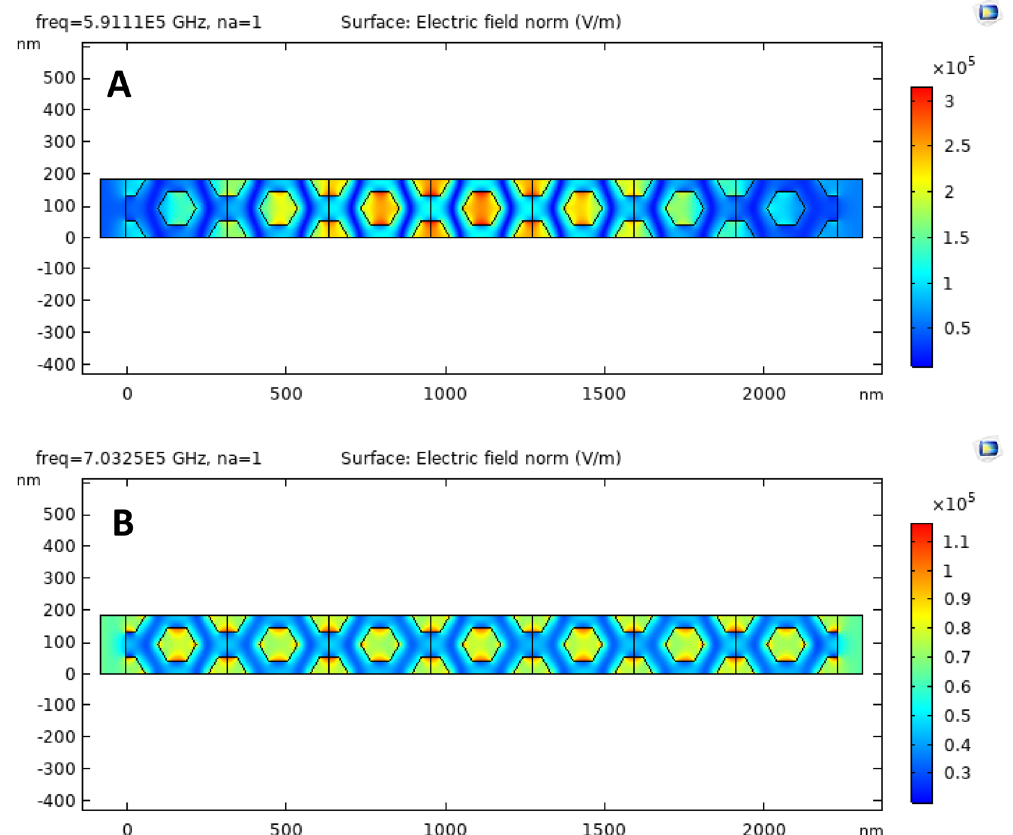
Figure 3. The electric field distribution inside the structure of a two-dimensional hexagonal cylinder unit cell with R = 80nm , D = 160nm, and all cylinders are filled with air at the host material of titanium dioxide ( TiO 2 ) . Also, N periods equal 7 for different values of incident frequency as in ( A ) and ( B